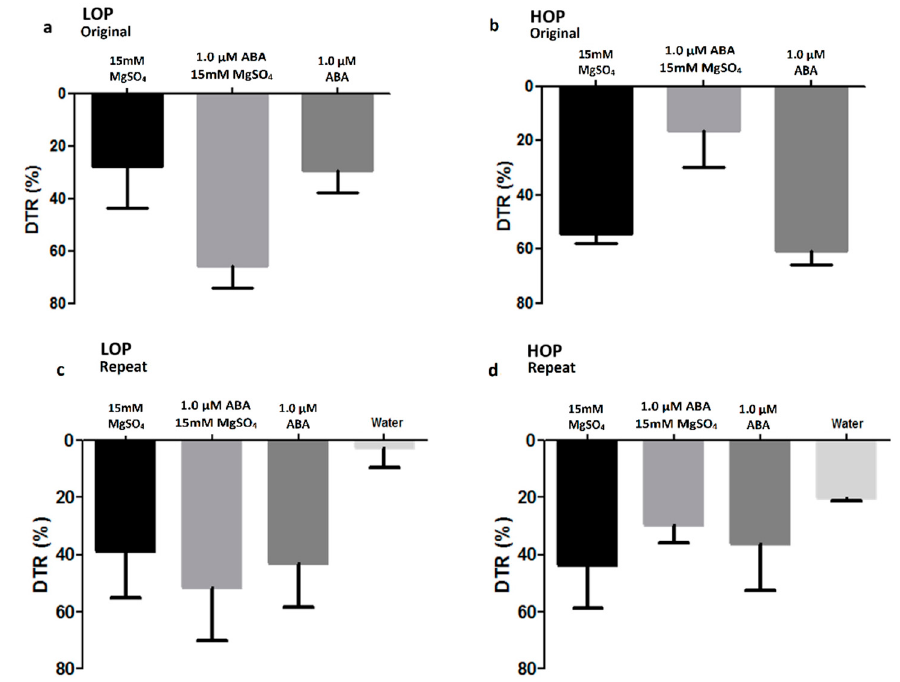
Figure 2. Decrease in transpiration response (DTR) of the detached leaves of two maize near-isolines LOP ( a , c ) and HOP ( b , d ) at 32/26 °C and high VPD ~3.2 kPa. The treatments were (ABA (1.0 µM), MgSO 4 (15 mM), and a combination (ABA (1.0 µM) + MgSO 4 (15 mM))). The plants grown on soil.